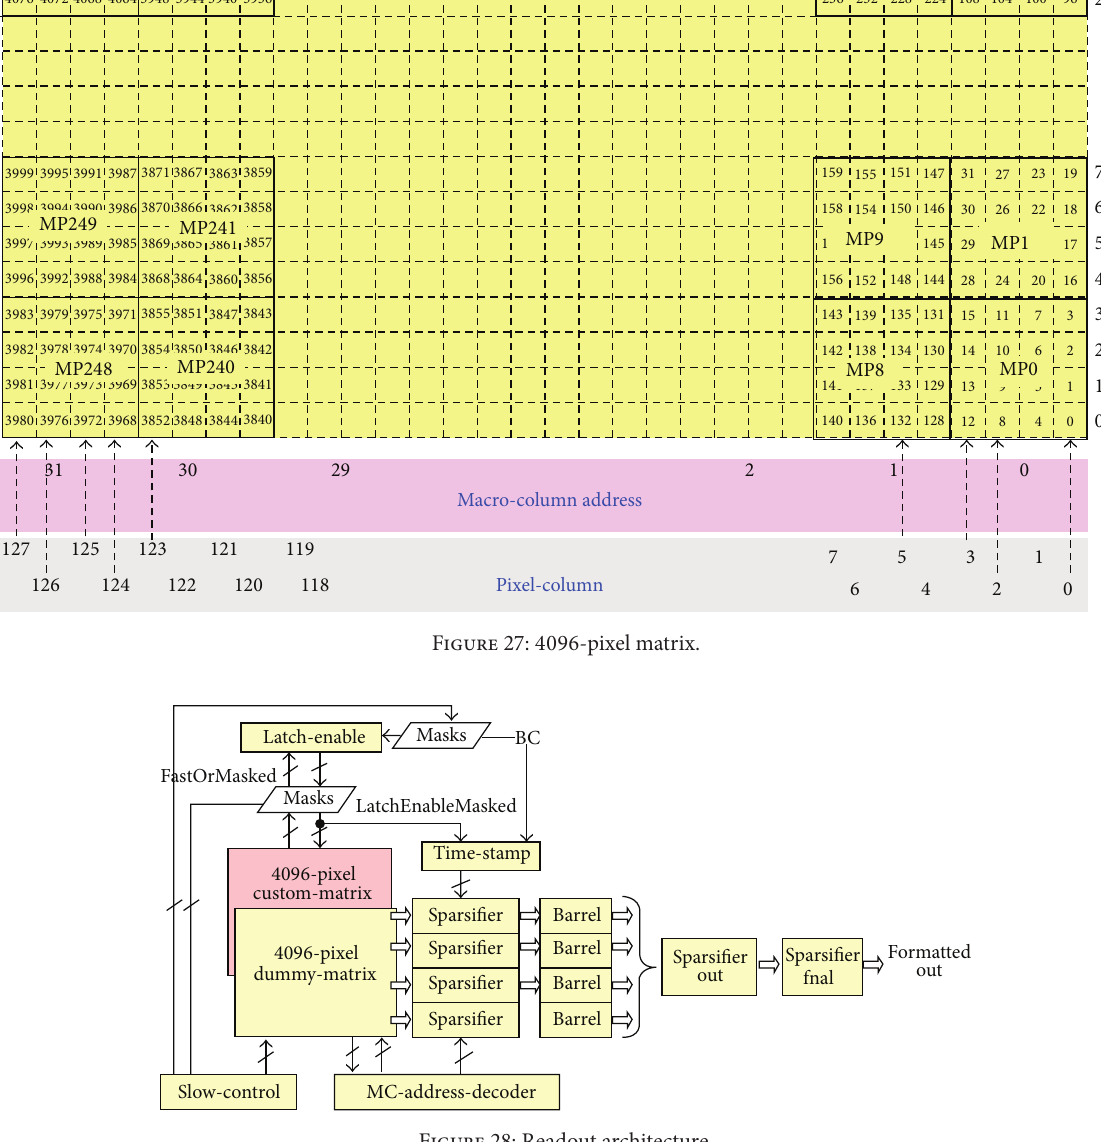
Figure 28: Readout